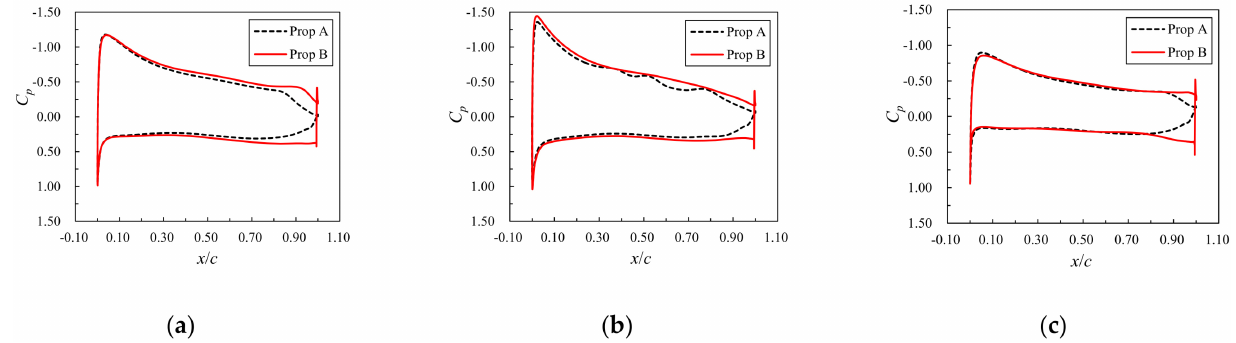
Figure 39. Pressure coefficient distribution on different cross-sectional airfoils at State 2: ( a ) r / R = 0.5; ( b ) r / R = 0.75; ( c ) r / R =